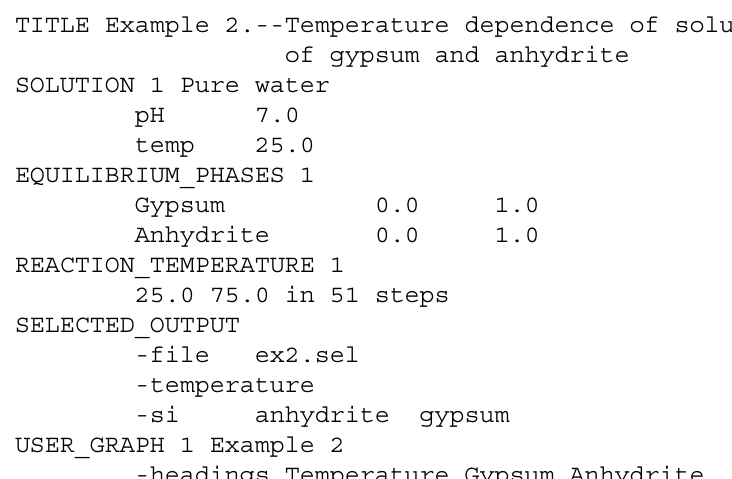
Table 12. Input file for example